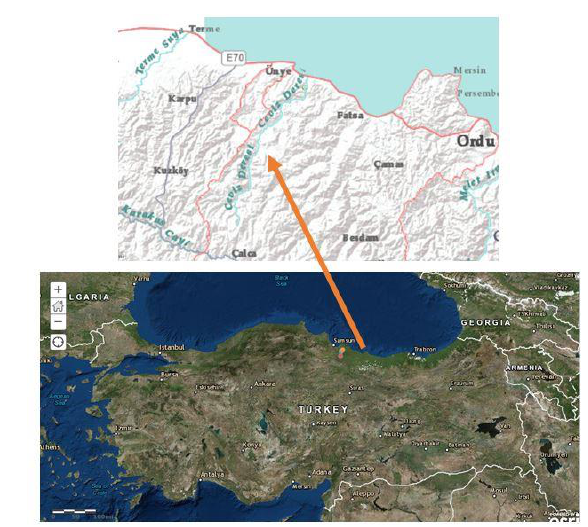
Figure 3: Geodatabase of watershed area on cloud